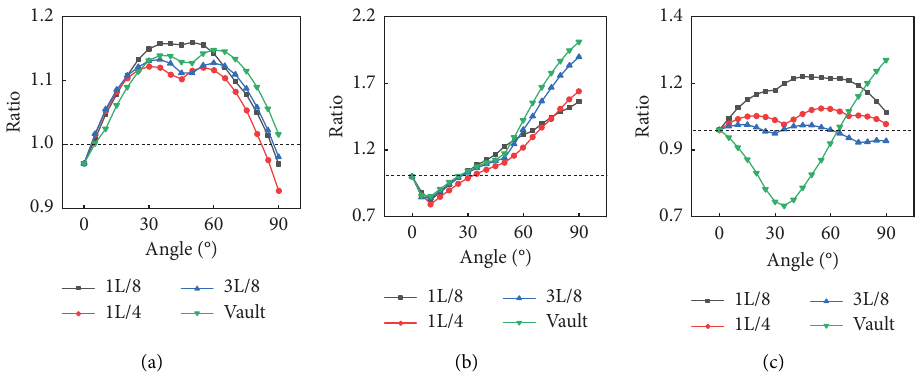
Figure 14: Upper chord displacement ratio under the X + Y combined multiangle excitation. (a) X direction, (b) Y direction, and (c) Z direction. Note . Te ratio in the fgure is the ratio of the chord displacement variation amplitude of the X + Y combination under multiangle and 0 ° seismic